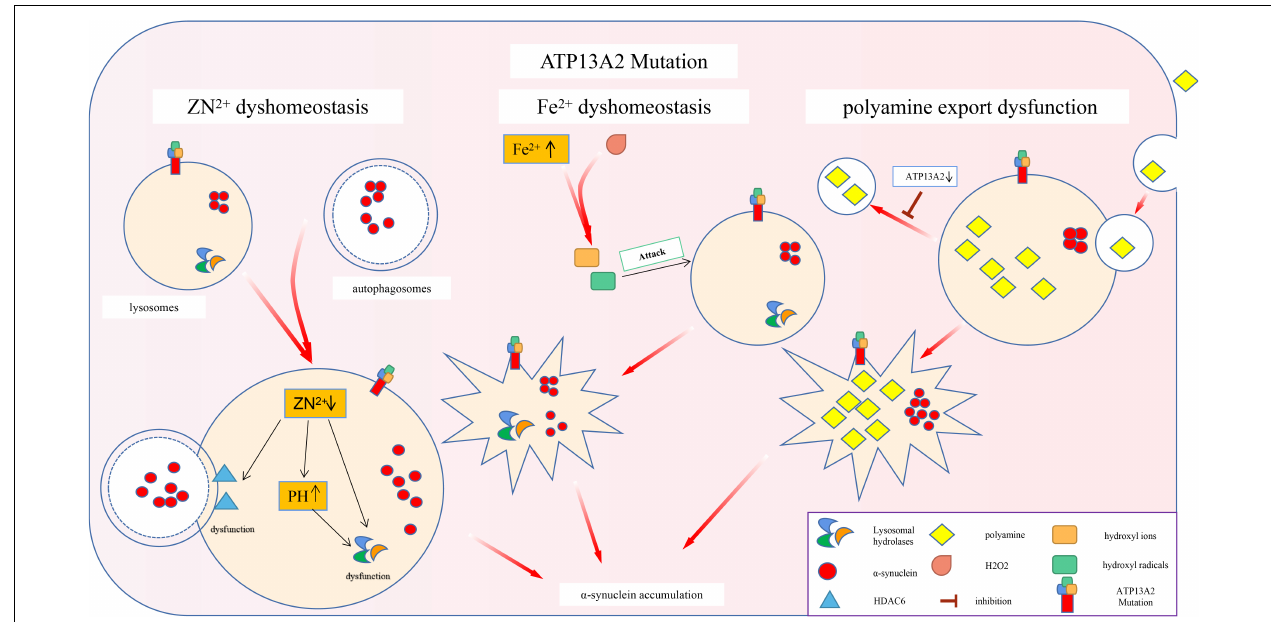
FIGURE 2 | Effects of ATP13A2 gene mutation on intracellular clearance of α -synuclein. Mutations in the ATP13A2 gene lead to a decrease in ATP13A2 protein expression in lysosomes, which directly leads to the homeostasis of Zn 2 + , Fe 2 + , and other metal ions and PAs, which in turn leads to impaired autophagy and pathological accumulation of α